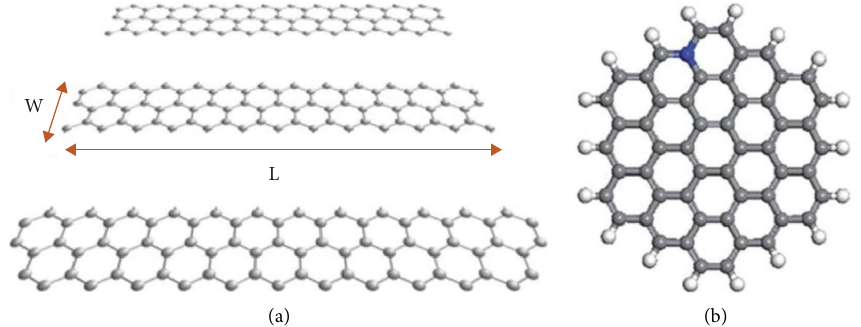
Figure 3: Typical shape of (a) graphene nanoribbons and (b) a graphene quantum dot [32, 33] (reprinted following the Creative Commons Attribution (CC BY) license